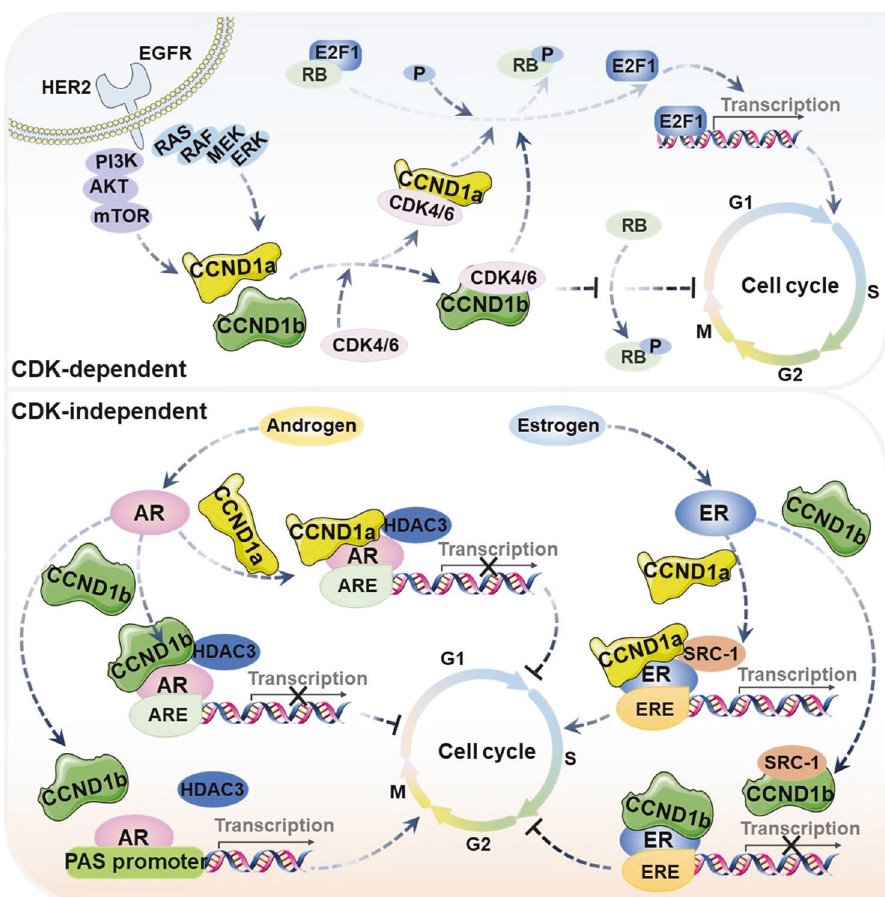
Fig. 3 Cell cycle regulated by CCND1 isoforms. In the CDK-dependent mechanism, CCND1 isoforms combine with CDK4/6 to form the CCND1a/b-CDK4/6 complex. This complex is involved in the regulation of cell cycle. In the CDK-independent mechanism, CCND1a and CCND1b regulate cell cycle by inducing ER/AR-mediated transcription in different